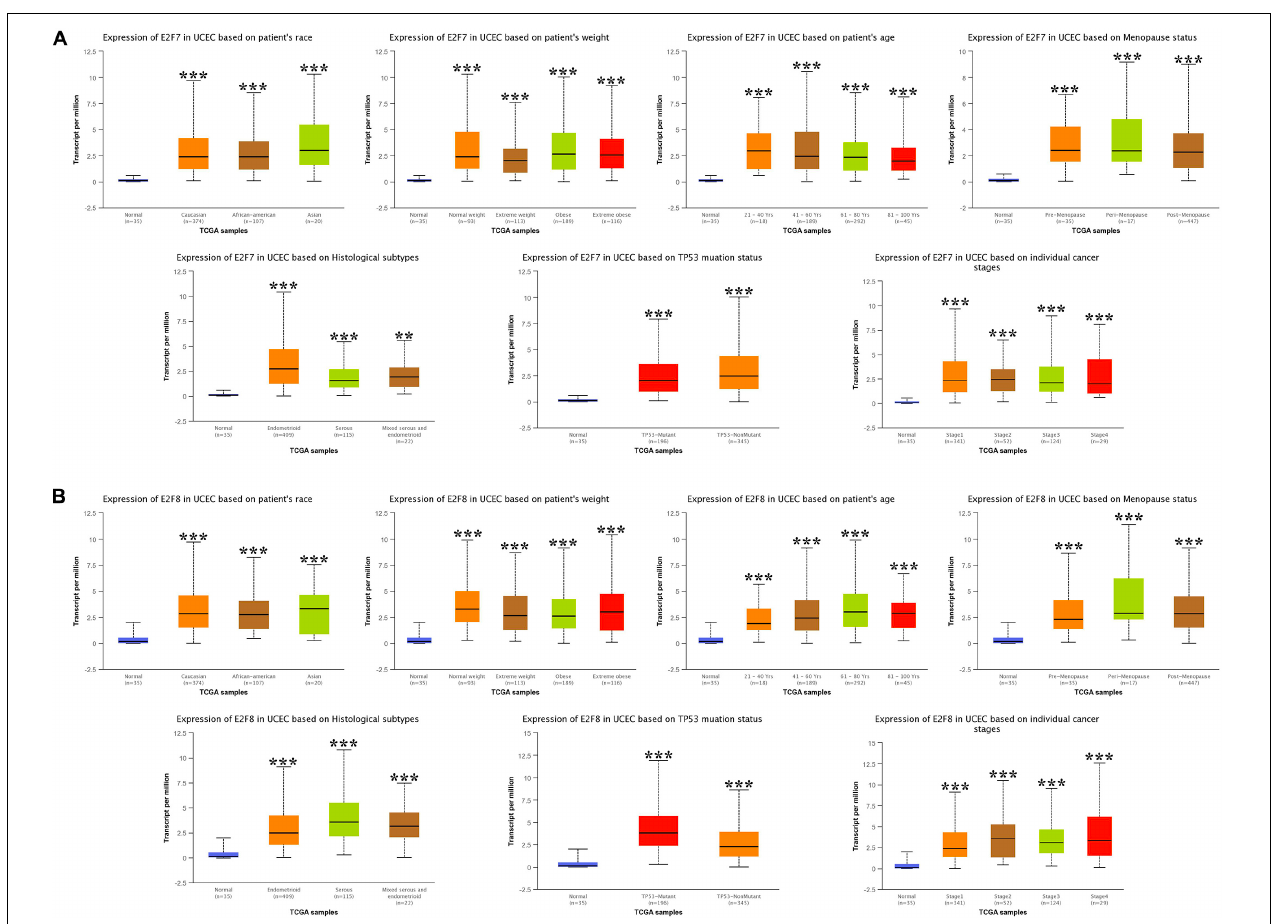
FIGURE 6 | The expression level of E2F7 and E2F8 in UCEC. (A) E2F7 expression in multiple subgroups of patients with UCEC, stratified along race, weight, age, menopause status, histological subtypes, TP53 mutation status, and cancer stage. (B) E2F8 expression in subgroups of patients with UCEC, stratified along race, weight, age, menopause status, histological subtypes, TP53 mutation status, and cancer stage. * P < 0.05; ** P < 0.01; *** P <